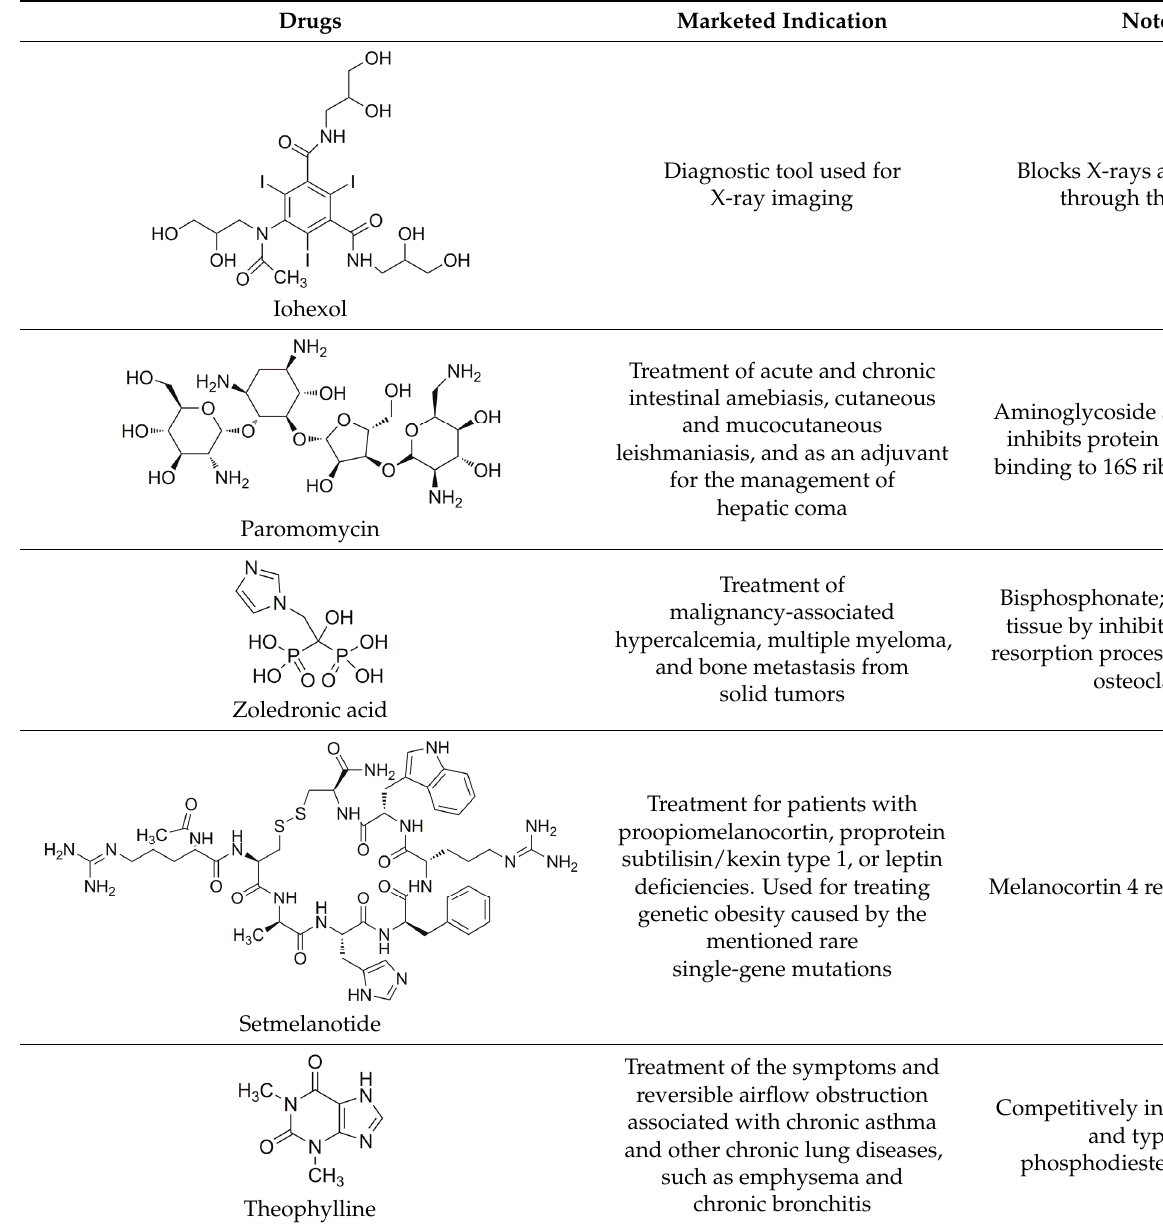
Table 5. The most promising FDA-approved drugs (with related features) potentially able to interfere with irisin dimerization.